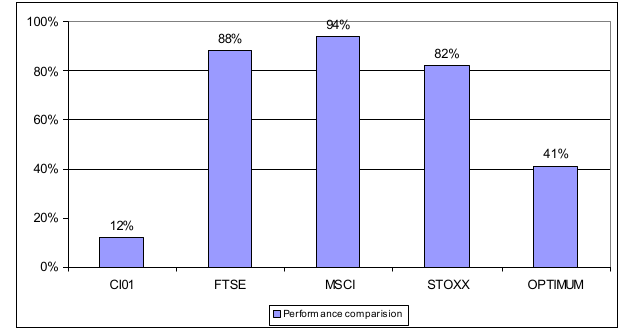
Figure 7: Percentage of unit trusts outperforming each